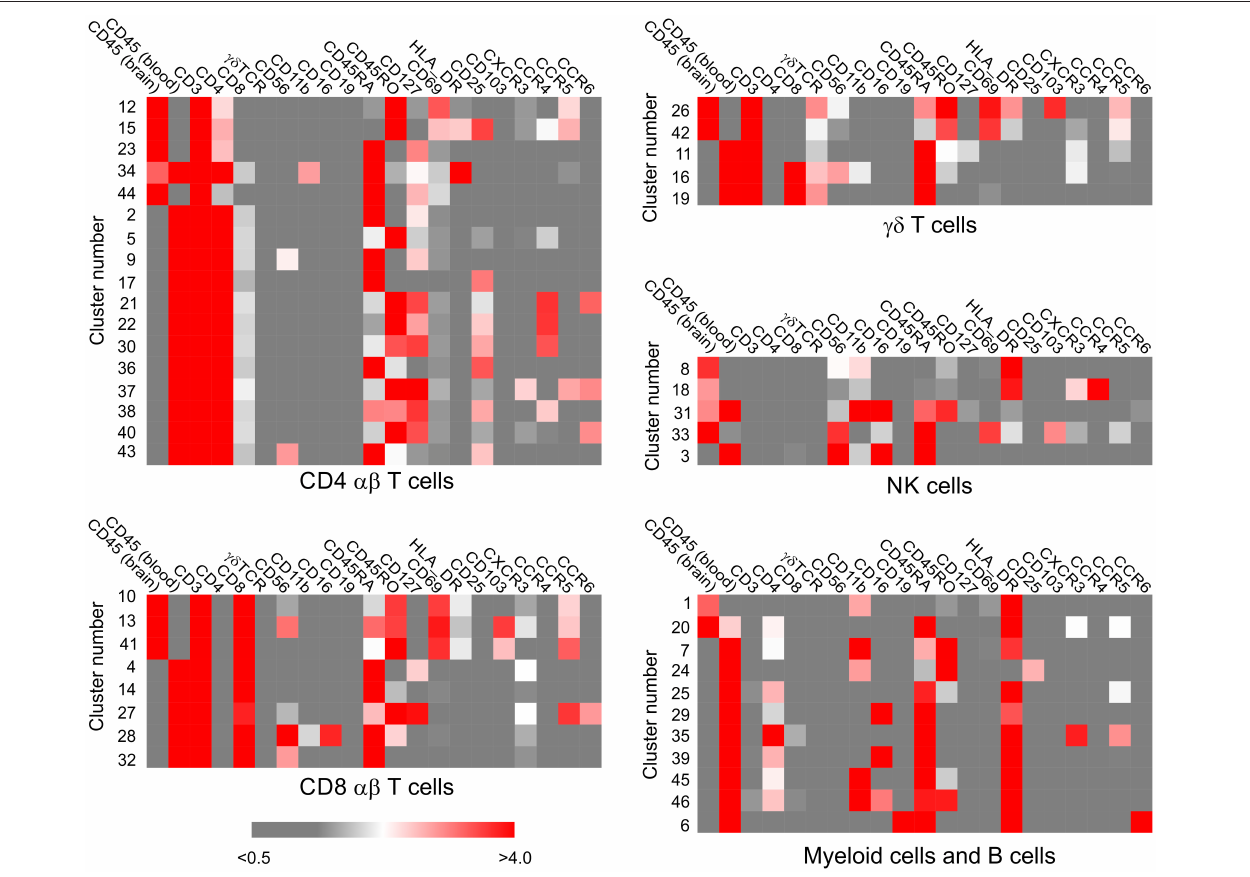
FIGURE 2 | Assignment of immune cell phenotypes. The median expression values of 19 immune cell markers, calculated by the Cytofit software, were used to assign a phenotype to each cluster of CD45 + cells ( Table S2 ). The data were first separated into CD3 + and CD3 − clusters, and the CD3 + populations were further subdivided into CD4 + , CD8 + , γδ subsets. The CD3 − populations were categorized as myeloid, natural killer cell, or B cell based on the expression of CD56 and CD19. Heat maps generated from the median expression values included all the markers that were expressed on cells in the CD3 + CD4 + , CD3 + CD8 + , CD3 + γδ + , CD3 − CD56 + , CD3 − CD19 + / − clusters, respectively. The median expression value of the two different CD45 antibody metal conjugates used to stain the PBMC and BIL fractions reflects the relative number of PBMCs and BILs in each